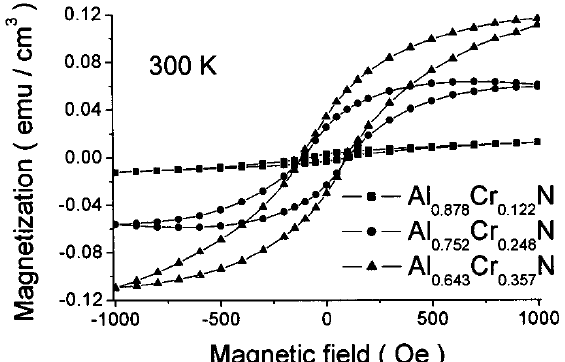
Figure 10. Magnetization of Al 1 − x Cr x N layers prepared by reactive co-sputtering displaying room temperature (RT) ferromagnetism and fixed coercivity for the entire Cr concentration range x = 0.12–0.36, pointing at the formation of secondary phases. Reproduced with permission from Reference